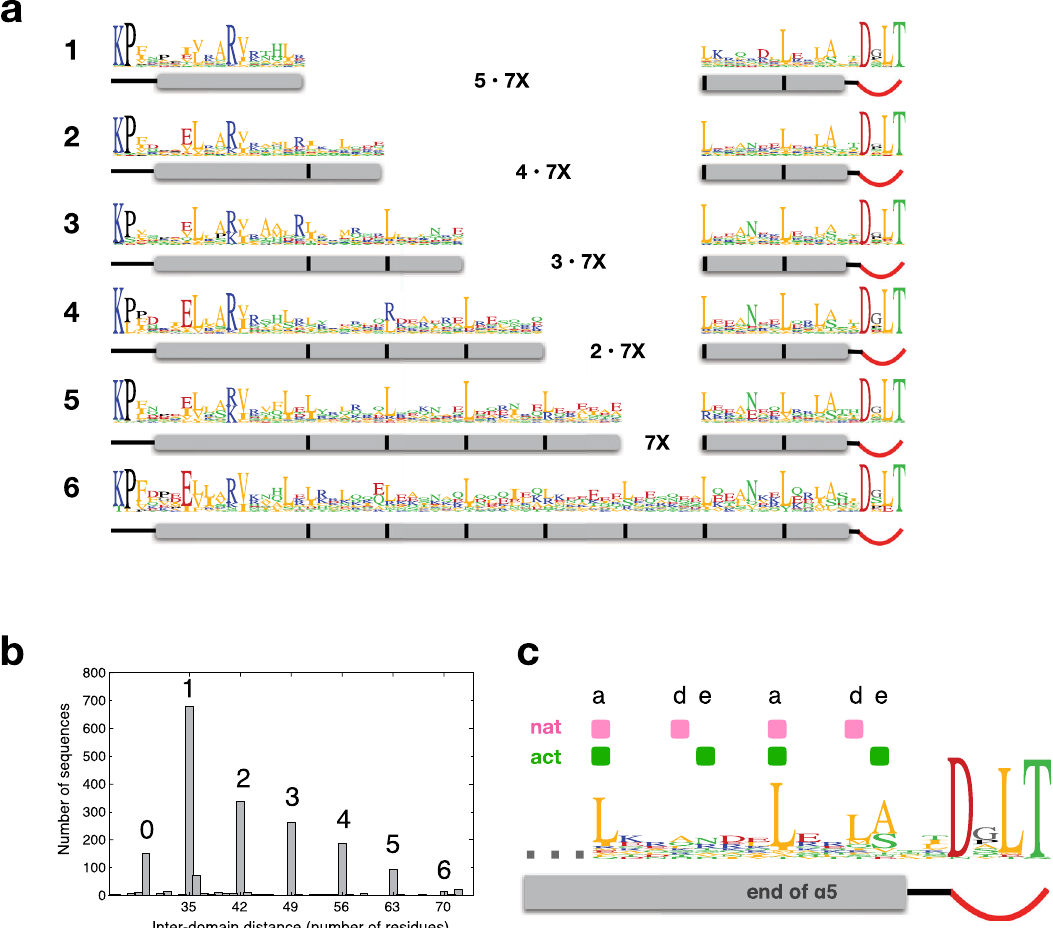
Fig. 10 The linker helices of Rec-GGDEF proteins show heptad repeat patterns and discretized lengths. a Sequence logos of inter-domain linkers grouped according to length. Logos 1 to 6 correspond to peaks 1 to 6 in the histogram of panel b. DgcR belongs to group 1. The grey rectangles symbolise the predicted α 5 helices, black bars indicate recurring hydrophobic positions spaced with a distance of 7. Data were compiled from 1991 Rec-GGDEF sequences, see Methods. b Histogram of inter-domain distances as measured from Rec KP motif to GGDEF DxLT motif. c Overall logo of C-terminal part of all sequences shown in panel a . Positions engaged in parallel coiled-coil interactions in DgcR ’ and DgcR ’ *, are indicated in pink and green, respectively (see also Fig.